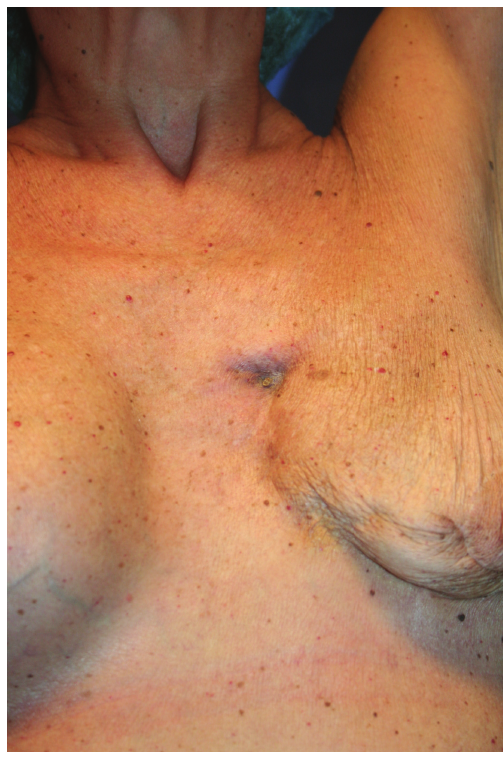
Figure 4: Breast fistula 20 days after fat graft (detail).